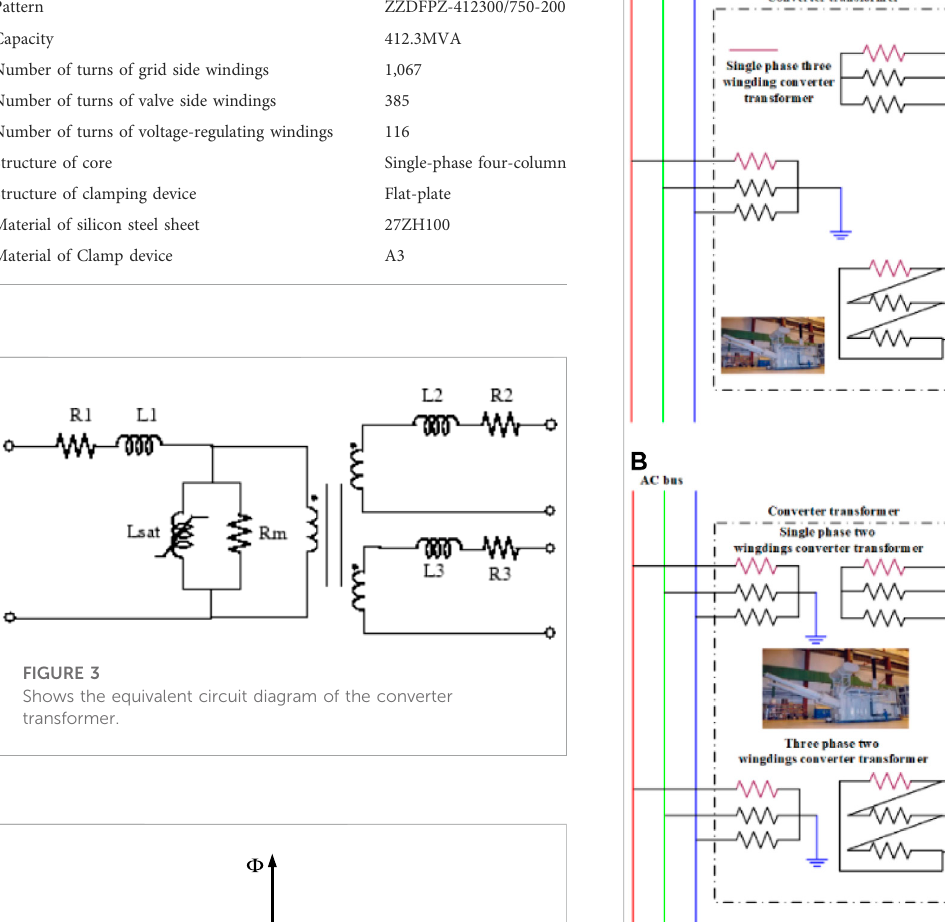
FIGURE 5 Convertertransformermainconnectionmode: (A) Converter transformer adopts single-phase three winding structure; (B) Converter transformer pole I high single-phase double winding structure, pole I low three-phase double winding